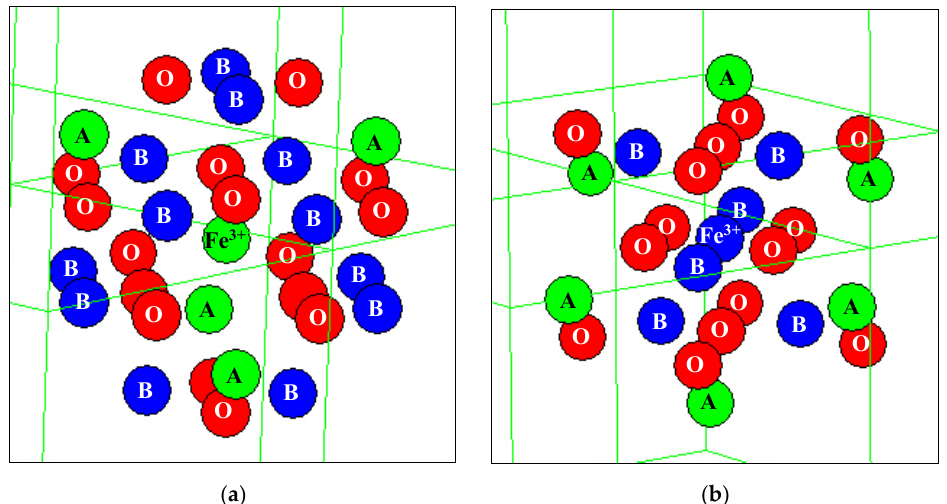
Figure 50. Local microenvironments of Fe 3+ cation in the (A) ( a ) and [B] ( b ) sites of the ideal NiFe 2 O 4 crystal: O (red circles) are O 2– ions, A (green circles) are tetrahedral sites occupied by Fe 3+ cations and B (blue circles) are octahedral sites occupied by both Fe 3+ and Ni 2+ cations. Adapted from Ref. [79]